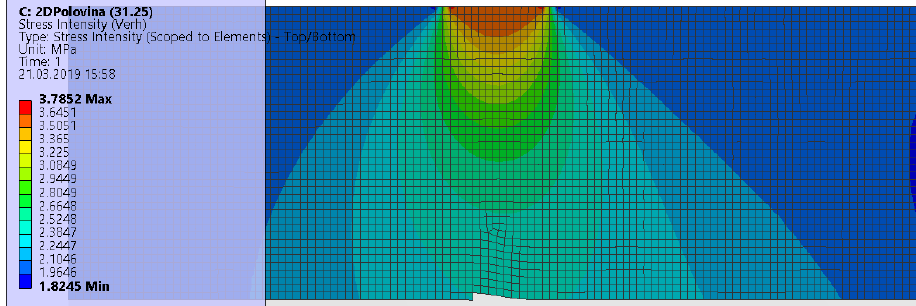
Fig. 9. Distribution of stresses σ y in the lower part of the deep beam